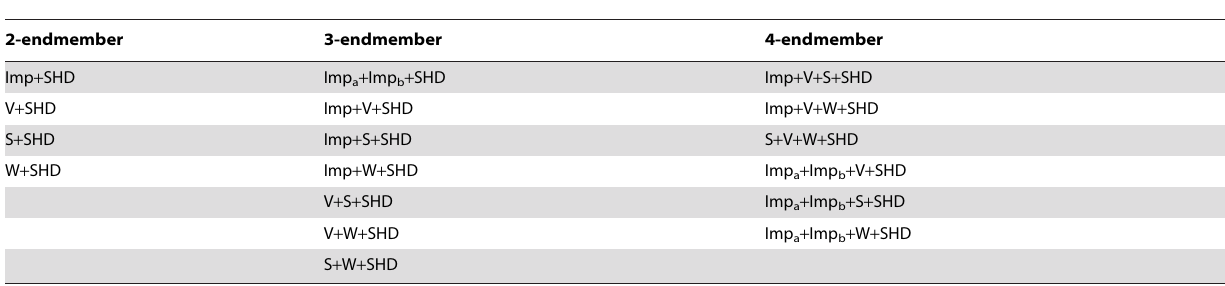
Table 1. Combinations of endmember models by land cover